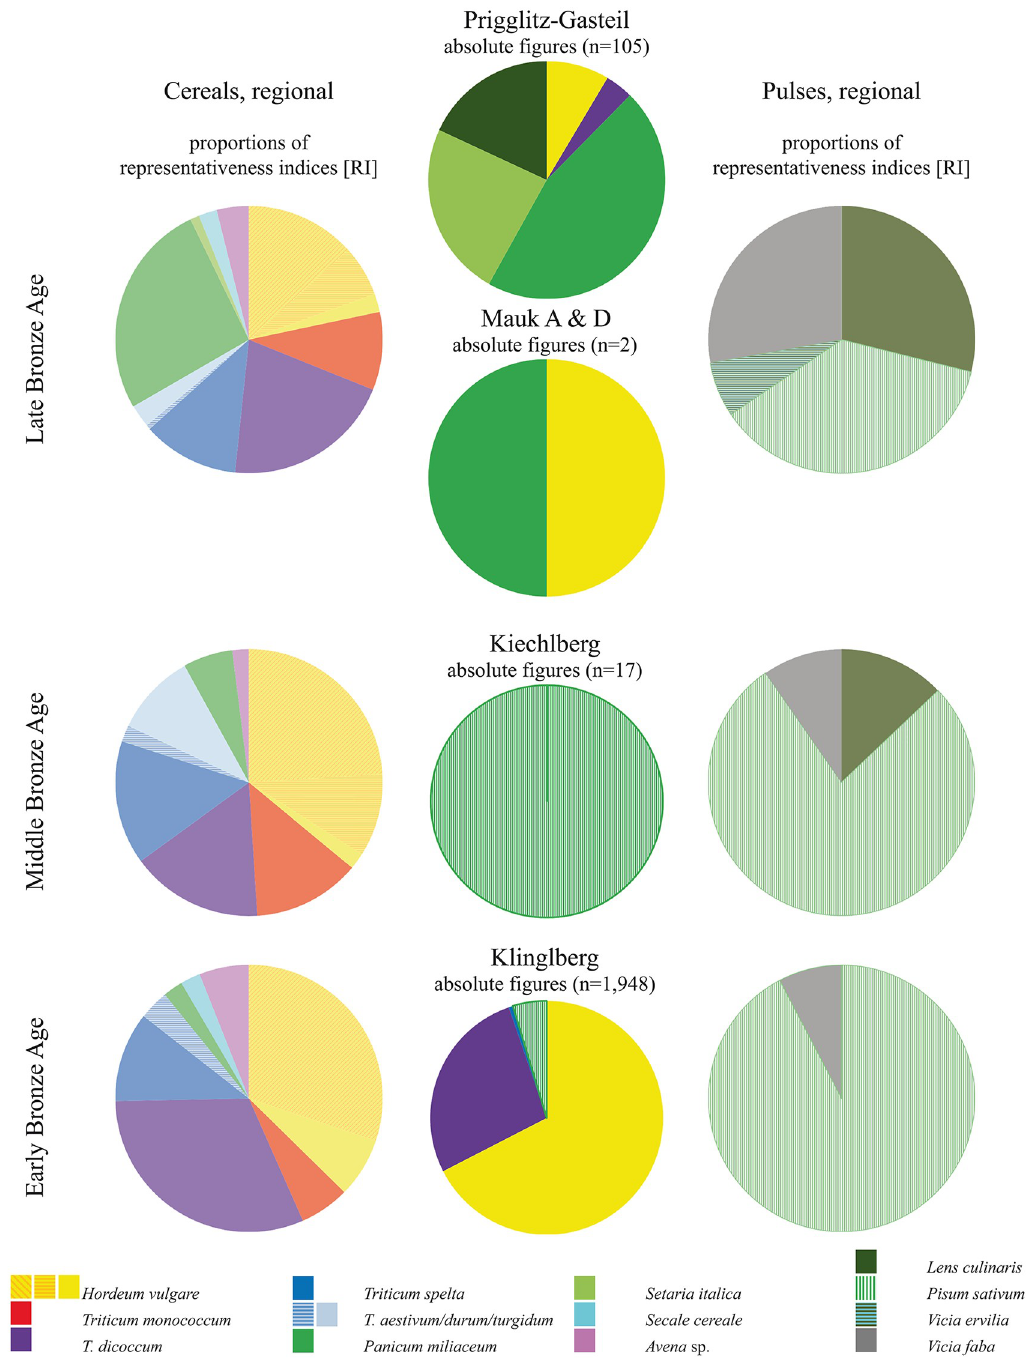
Fig 19. Comparative crop plant spectrum from Prigglitz-Gasteil. Cereals from Fig 3 complemented with the lentil finds from S1 Table. Central row: diachronic comparison to the results from Klinglberg [17], Kiechlberg [16, 26], and Mauken [data from 6, 12, 27]. To provide easier comparison to already published data, all count numbers were modified according to the procedures explained in section 2.3.4. Left and right rows: regional diachronic data for cereals and pulses, displayed via their respective representativeness indices (RIs) from the region “Eastern Alps and their Foreland” as published by Stika & Heiss [177, 178]. Illustration: OeAW-OeAI/A. G. Heiss.